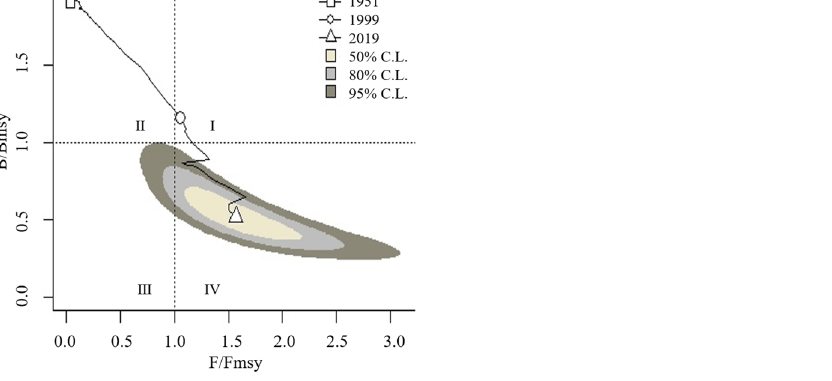
Figure 2. Diagram of fishery status of China marine capture fisheries, based on the time series of fishing pressure ( F/F msy ) and of population status ( B / B msy ), at different confidence limits. 1951 and 2019, the start year and the end year of official statistics; 1999, the first year of the “zero-growth” policy.